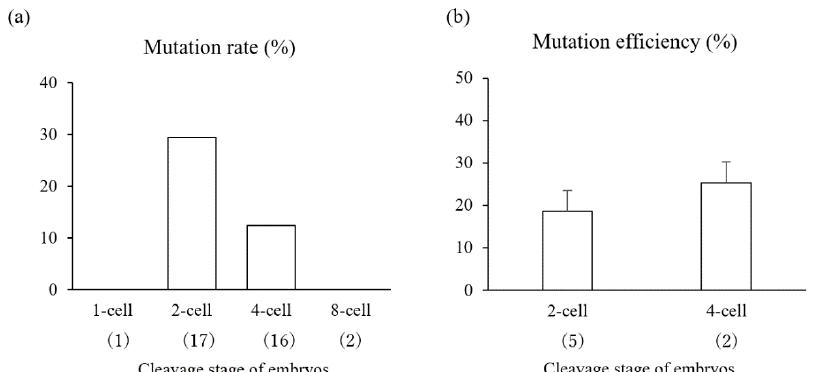
Figure 2. Mutation rate ( a ) and mutation efficiency ( b ) of blastocysts derived from zona pellucida (ZP)-free embryos at different cleavage stages subjected to lipofection-mediated gene editing with gRNA targeting PDX1 . Embryos at the 1- to 8-cell stage were collected at 29 h from the start of in vitro fertilization and then exposed to LF2000, gRNA, and Cas9 protein for 5 h. ( a ) Mutation rate was defined as the ratio of the number of edited blastocysts to the total number of sequenced blastocysts. ( b ) Mutation efficiencies represent the proportion of indel mutation events in gene-edited blastocysts. The numbers within parentheses indicate the total number of blastocysts examined. Four replicate trials were carried out. Each bar represents the mean ±